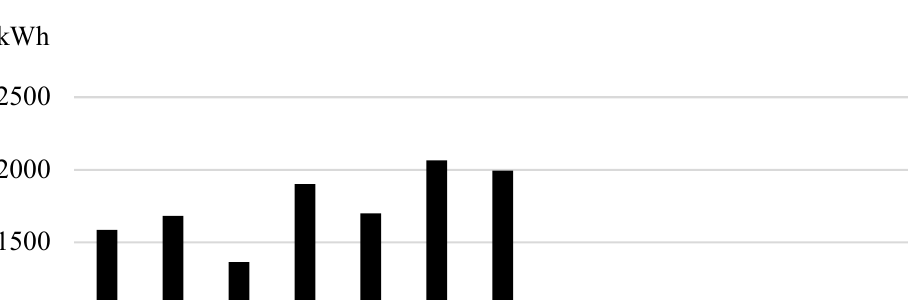
Figure 9. Recorded PAT mechanical efficiency compared to the one calculated by the selection software.